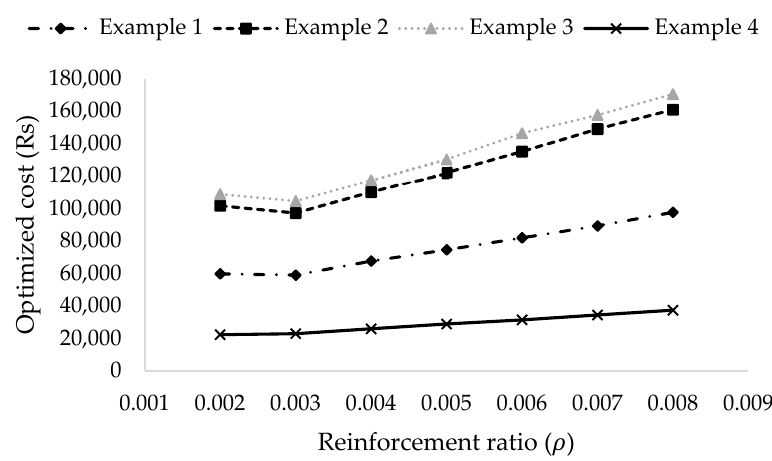
Figure 12. Effect of reinforcement ratio on cost by the GA.